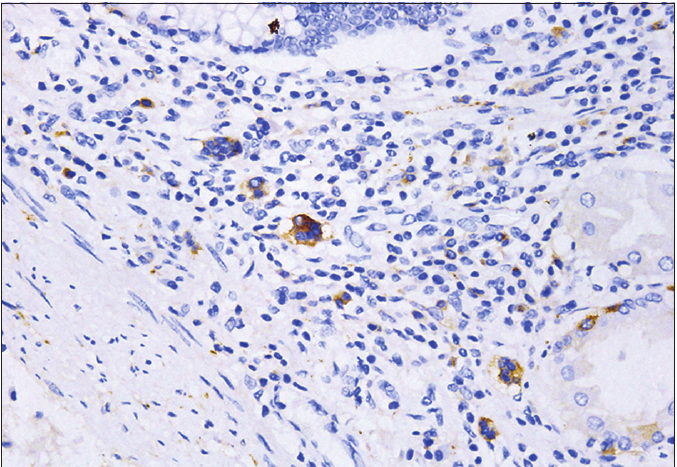
FIGURE 2. Micronodular neuroendocrine cell hyperplasia was seen in deep part of the lamina propria (Synaptophysin, ×200)